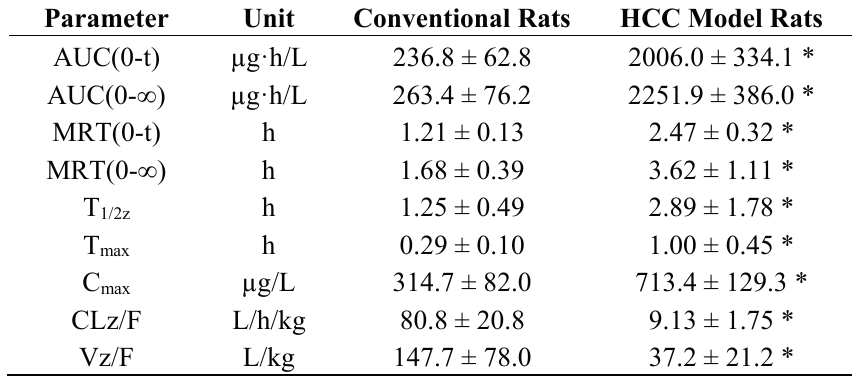
* p < 0.05, compared with the conventional